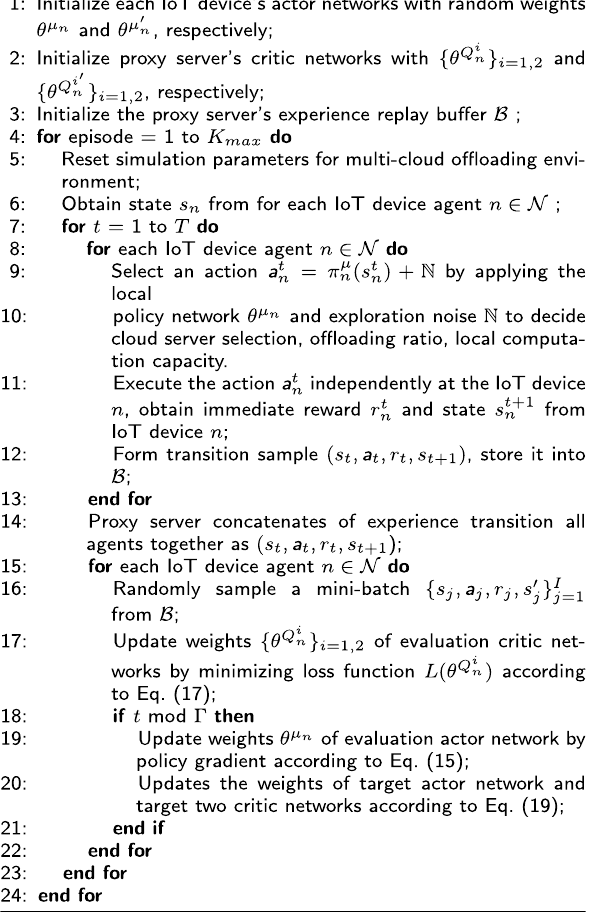
Algorithm 1 Training stage for computation